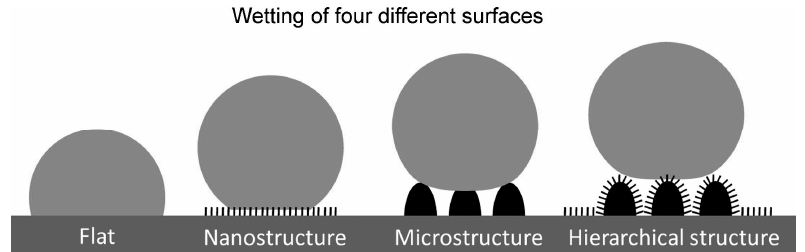
Figure 6. Schematic of four different surface structure types and their wetting behaviors. Reprinted with permission from [34]. Copyright 2016 Elsevier.